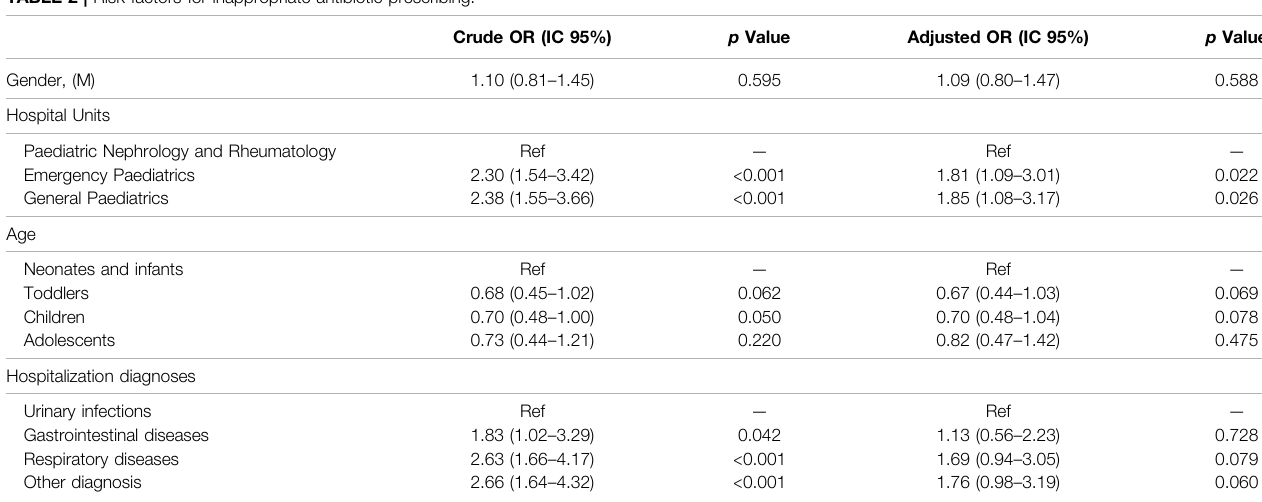
TABLE 2 | Risk factors for inappropriate antibiotic